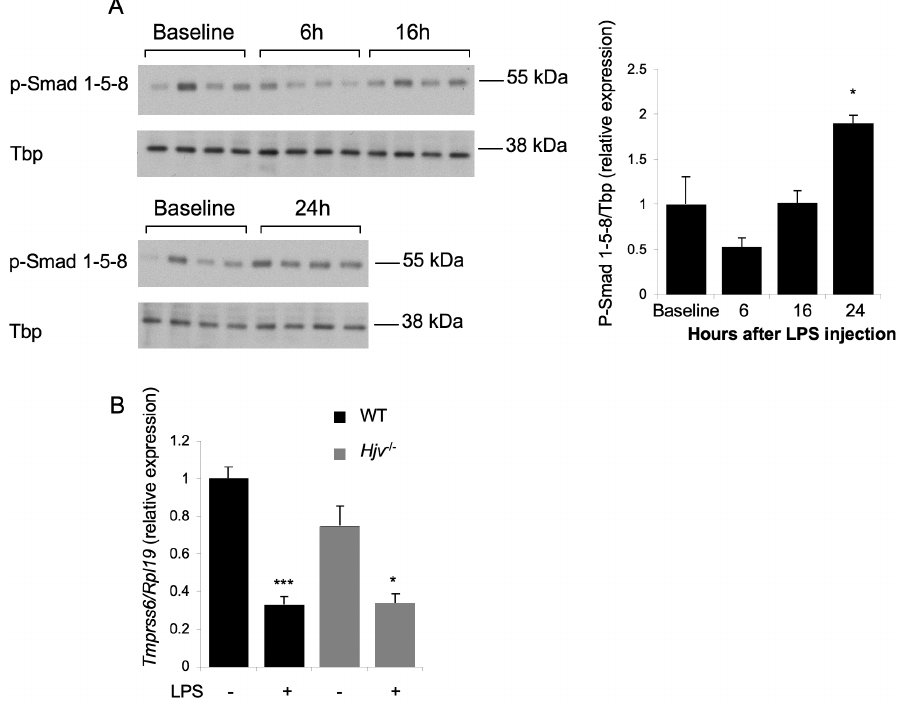
Figure 2. TMPRSS6 downregulation by inflammation is not dependent on the BMP-SMAD pathway. (A) Liver nucleic lysates from mice were analyzed by Western blot for p-Smad1-5-8 relative to TBP. Values shown are means of expression values divided by a calibrator quantity (the mean value of expression for the baseline group) + / 2 SEM. Means in baseline and treated groups were compared by student t tests. (B) WT and Hjv 2 / 2 littermate mice were injected with LPS (n=4 per group) and sacrificed 6 hours later. Tmprss6 relative to Rpl1 9 mRNA expression was analyzed by quantitative real-time RT- PCR. Values shown are means of expression values divided by a calibrator quantity (the mean value of expression for the mock group) + / 2 SEM. Means in mock and treated groups were compared by student t tests. P values p , 0.05 were considered statistically significant. Significances are: *p , 0.05; ***p , 0.005.